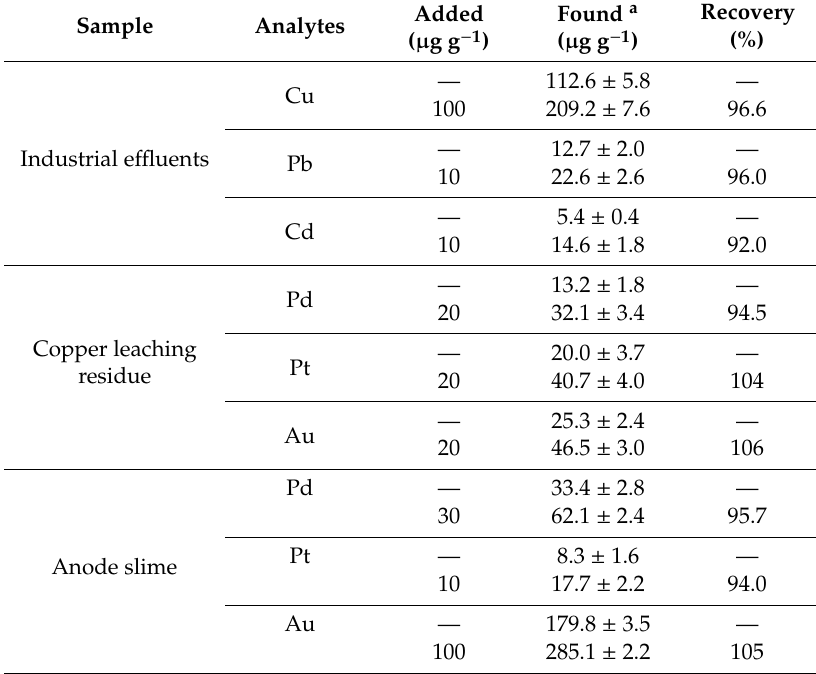
Table 3. Standard addition method for HM ions and NM ions determination in industrial e ffl uents and copper leaching residue, anode slime, respectively.